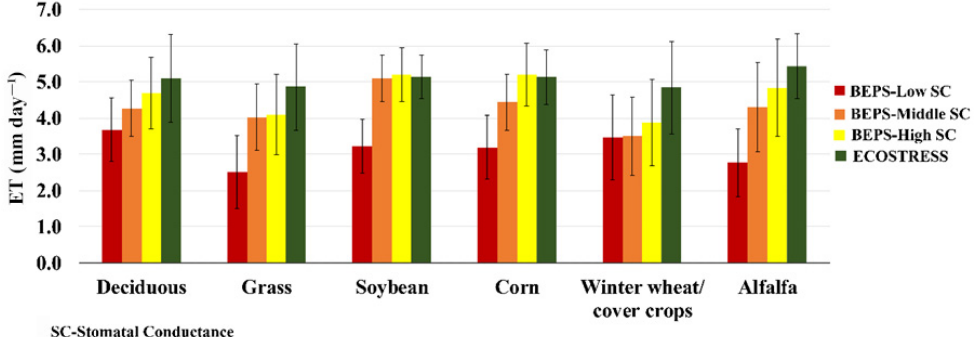
Figure 13. Comparison of the BEPS-estimated ET rates under the three stomatal conductance scenar-